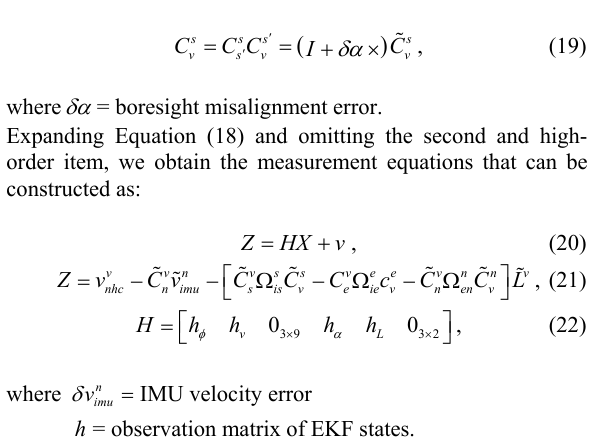
where  attitude misalignment